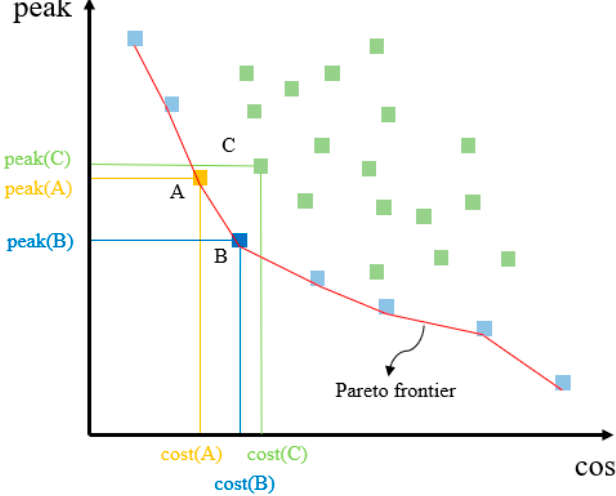
Figure 3. Pareto frontier of multi-objective optimization.